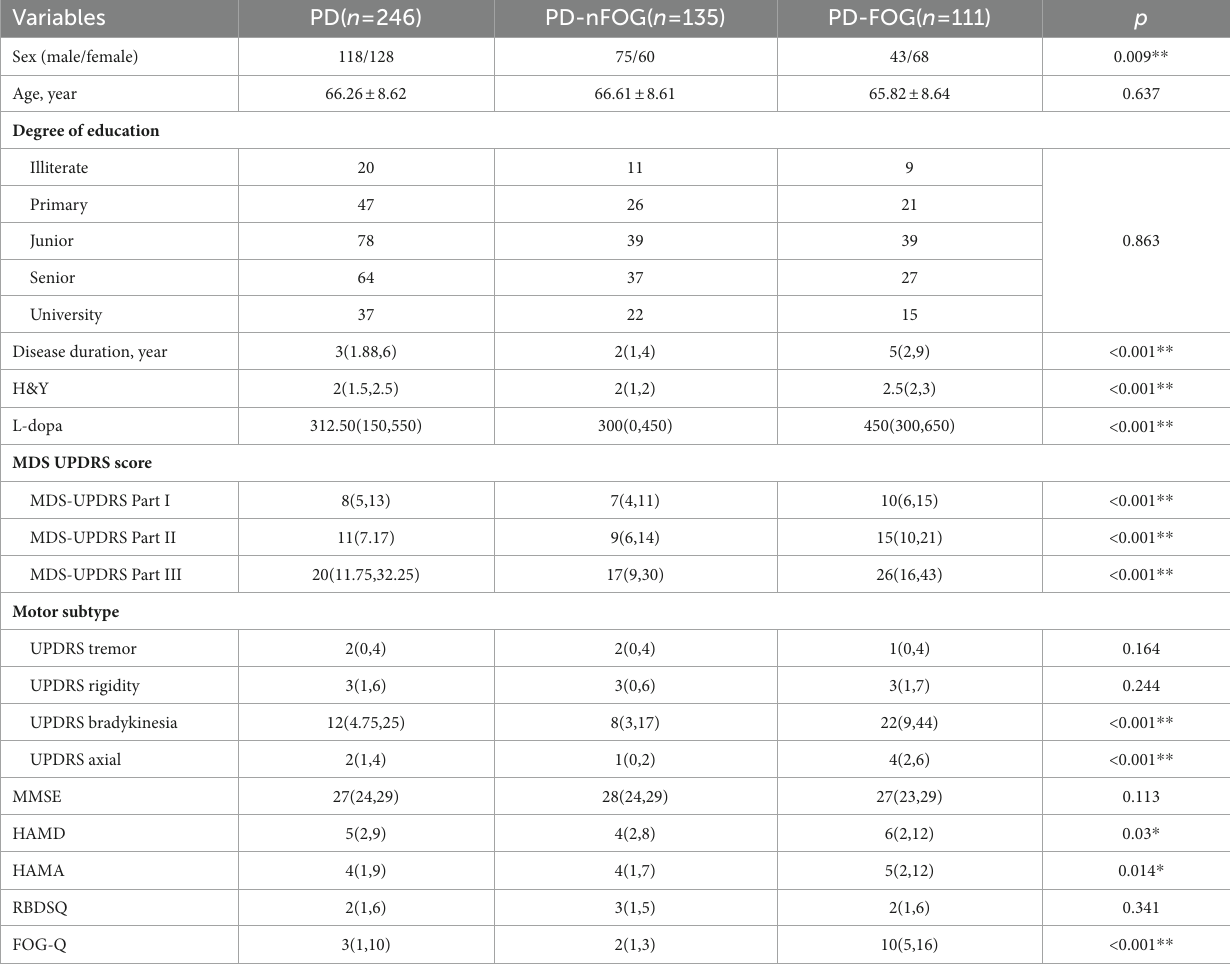
TABLE 1 Comparison of demographic and clinical characteristics of the two participant